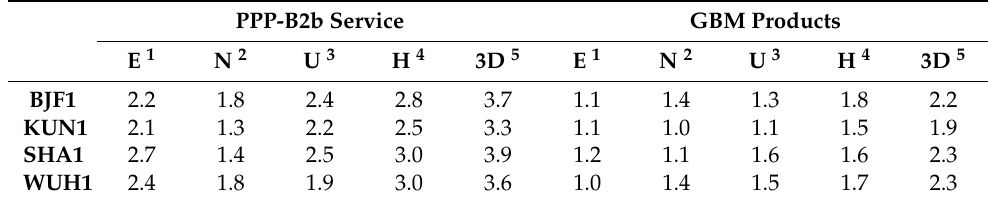
Table 5. The average positioning accuracy at the four stations (unit: cm).